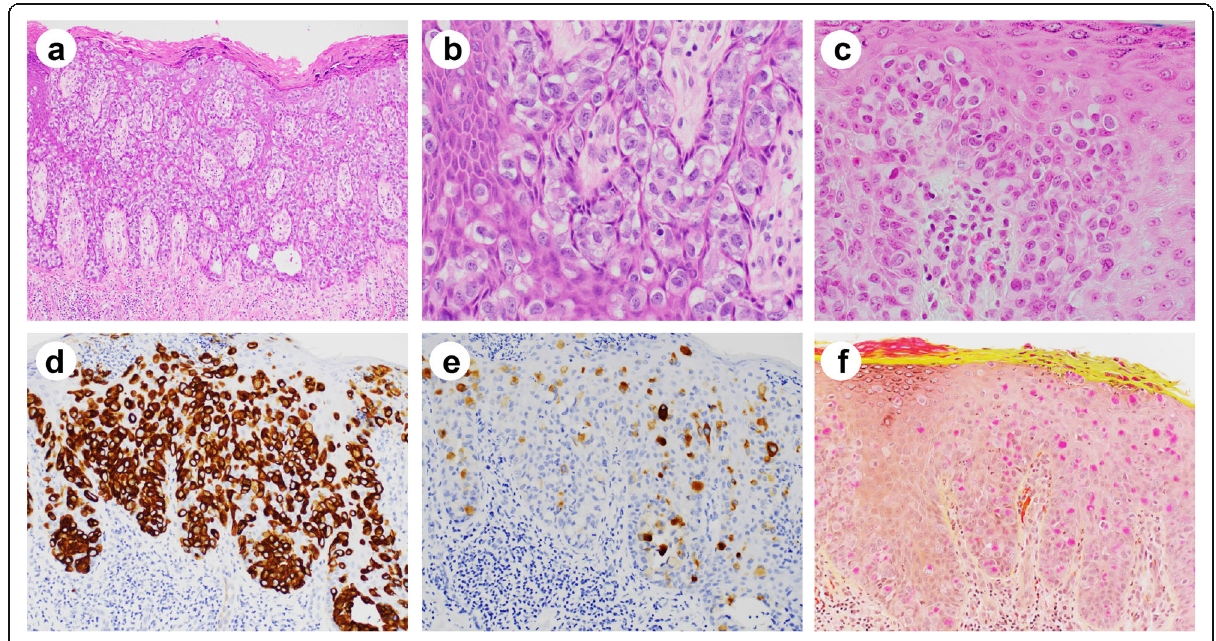
Fig. 1 Histologic features and special stains of Paget ’ s cells in primary perianal Paget ’ s disease. a , b Paget ’ s cells in primary perianal Paget ’ s disease are large, hyperchromatic with pale cytoplasm and prominent nucleoli (hematoxylin and eosin; a, × 100; b, × 400). The Paget ’ s cells in primary perianal Paget ’ s disease ( c , hematoxylin and eosin) are positive for CK7 ( d ) and GCDFP-15 ( e ) by immunohistochemistry. f Mucicarmine stain highlights intracellular mucin. Magnifications: c-f, × 200